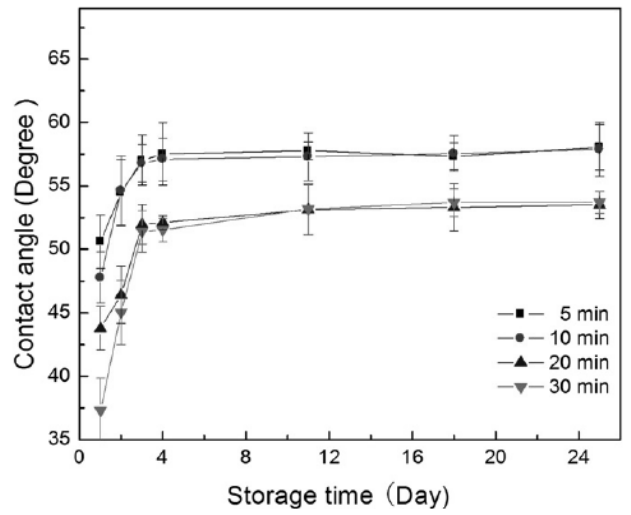
Figure 10. Thermodynamic recovery of the treated surface over storage time after modification (Reprinted with permission from [44]. Copyright 2011